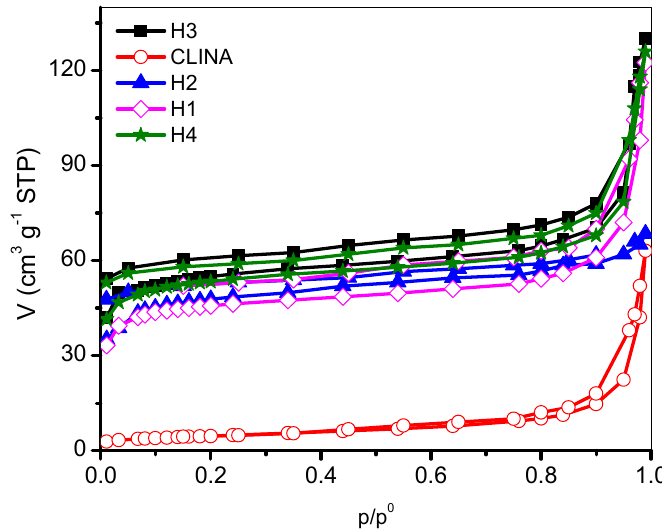
Figure 5. N 2 adsorption isotherms at 77 K on CLINA and H ‐ modified zeolites.